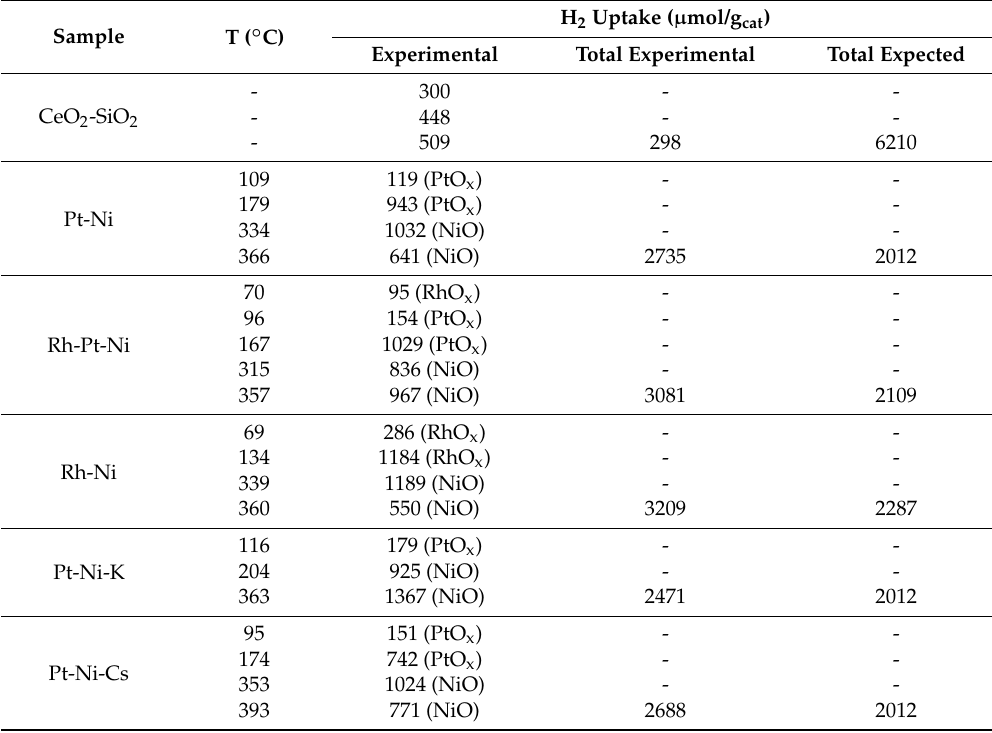
Table 2. Comparison between experimental and theoretical amounts of hydrogen consumption during